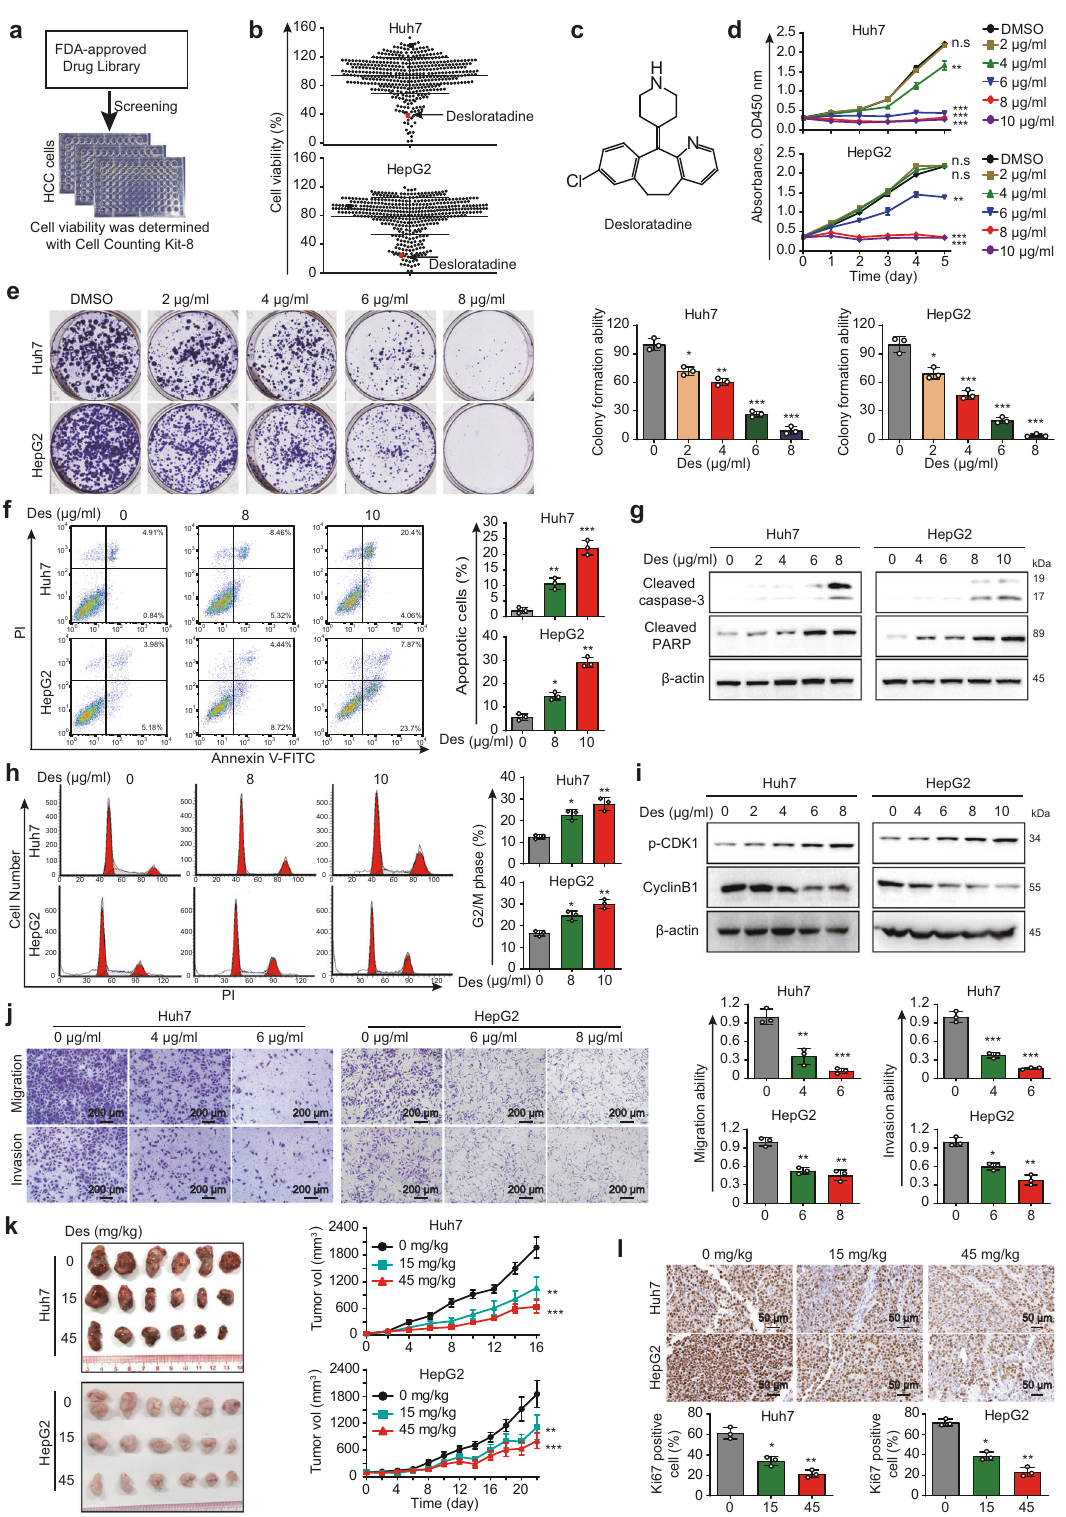
Desloratadine inhibits NMT1-mediated myristoylation of the VILIP3 protein Since both the mRNA and protein levels of NMT1 remained substantially unchanged when HCC cells were exposed to different concentrations of desloratadine (Supplementary Fig.